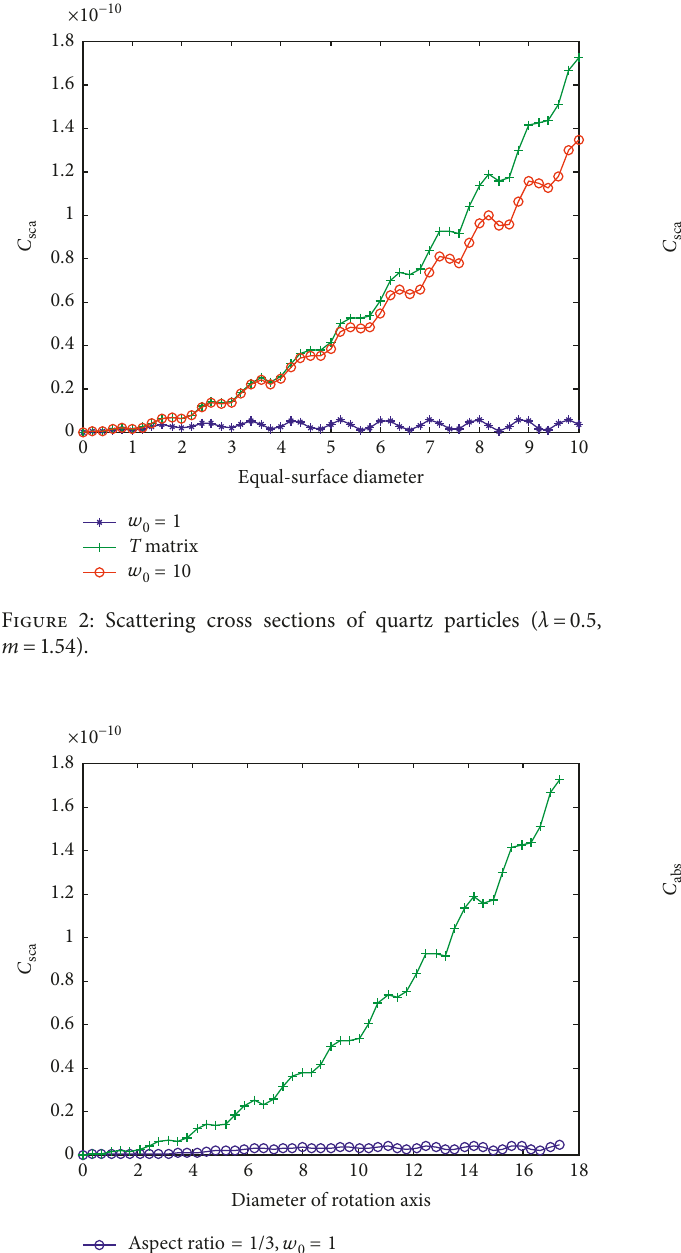
Figure 3: Scattering cross sections of quartz particles (aspect ratio 1/3, λ 0.5, m 1.54). (cid:31) (cid:31) (cid:31)